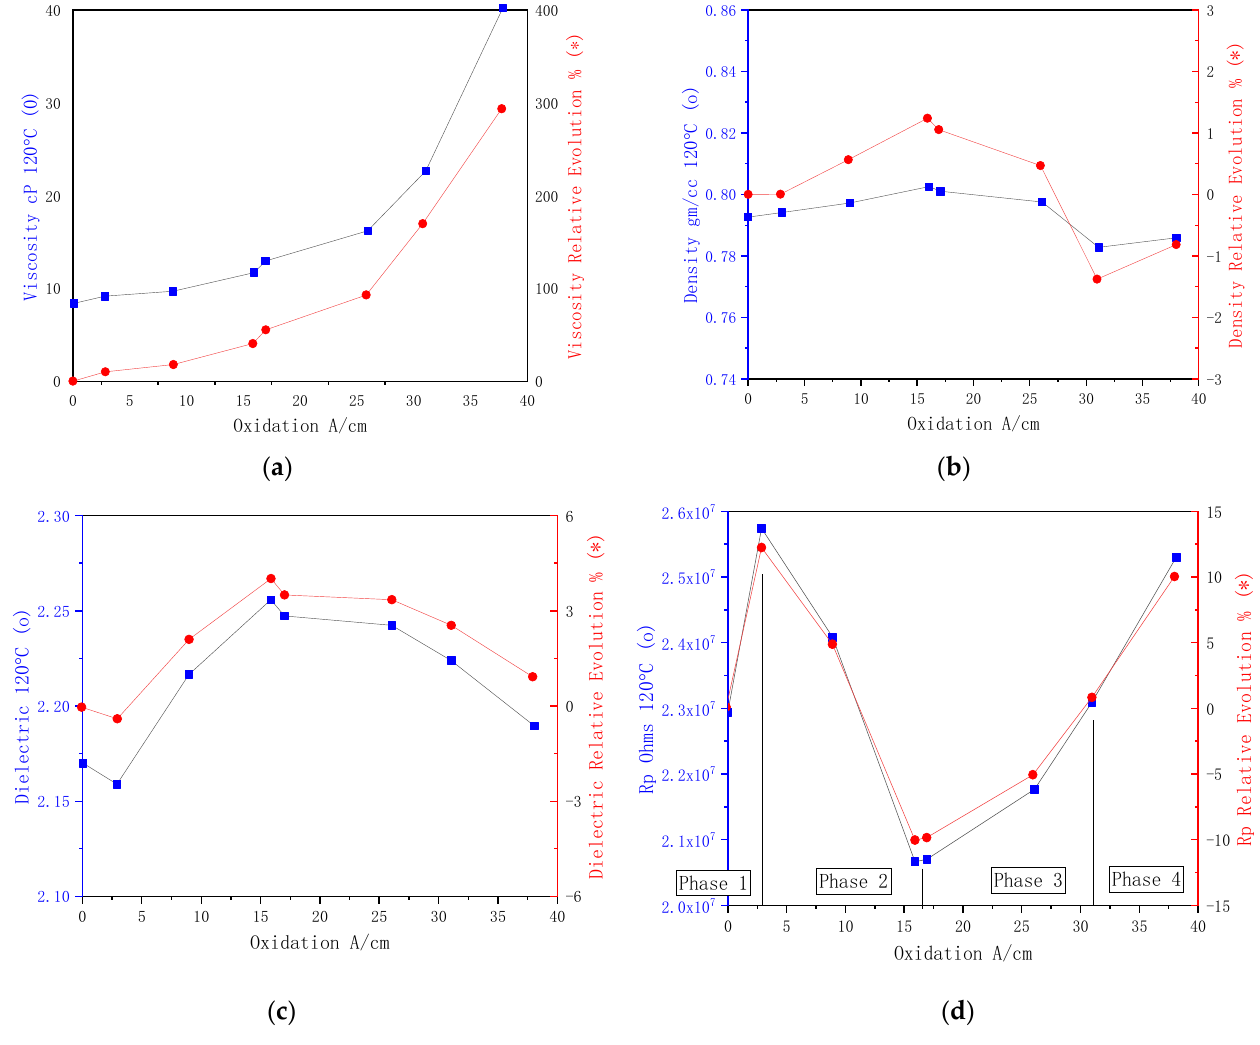
Figure 7. Engine oil (15W40) oxidation at 120 °C: ( a ) viscosity; ( b ) density; ( c ) dielectric; and ( d ) Rp. Viscosity is highly increased during all oxidation processes. Resistivity is a very use- ful parameter because it can be directly linked to the four different phases of the oil oxi- dation process (see Table 2). Table 2. Four different phases of oil oxidation process.